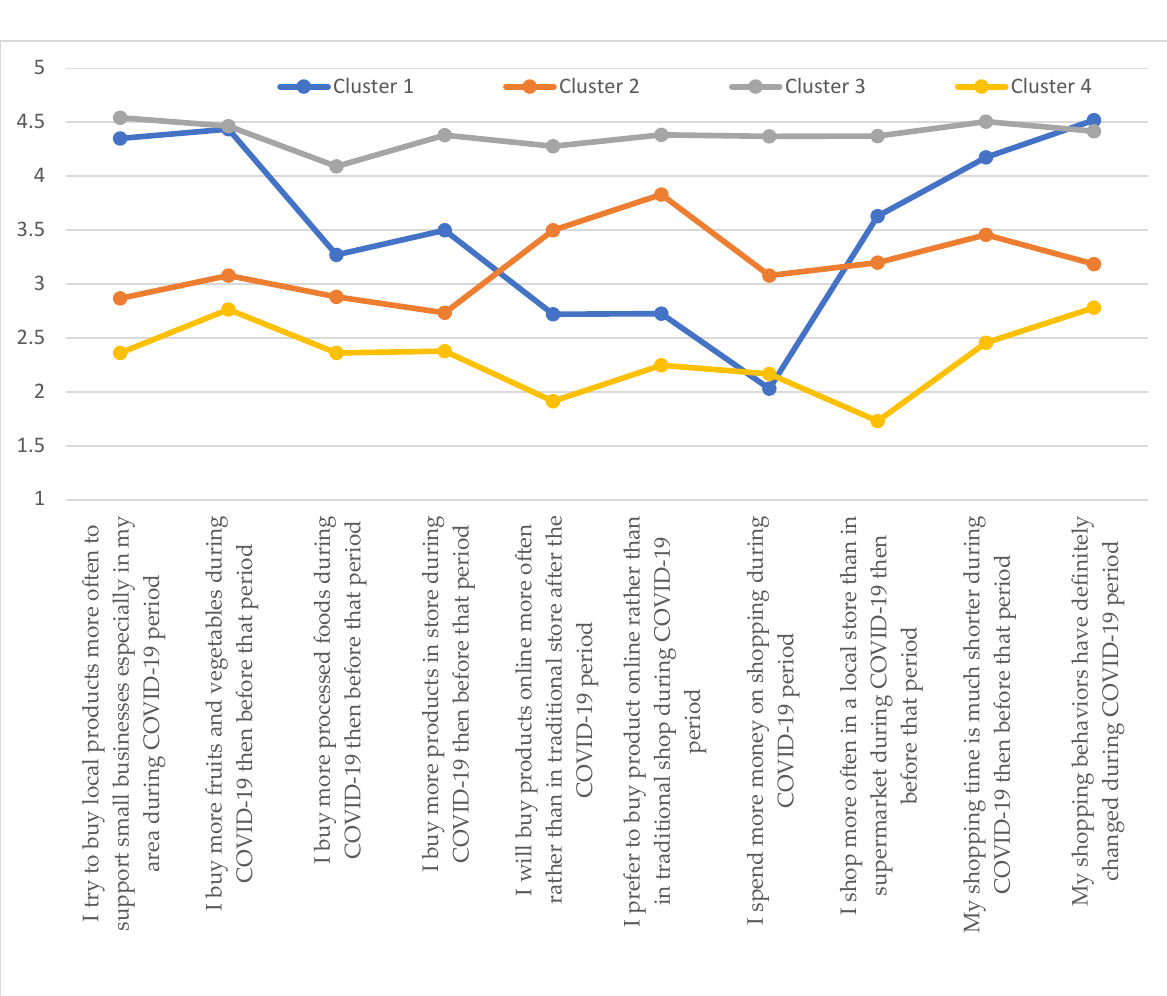
Figure 1. Cluster analysis: all international students.